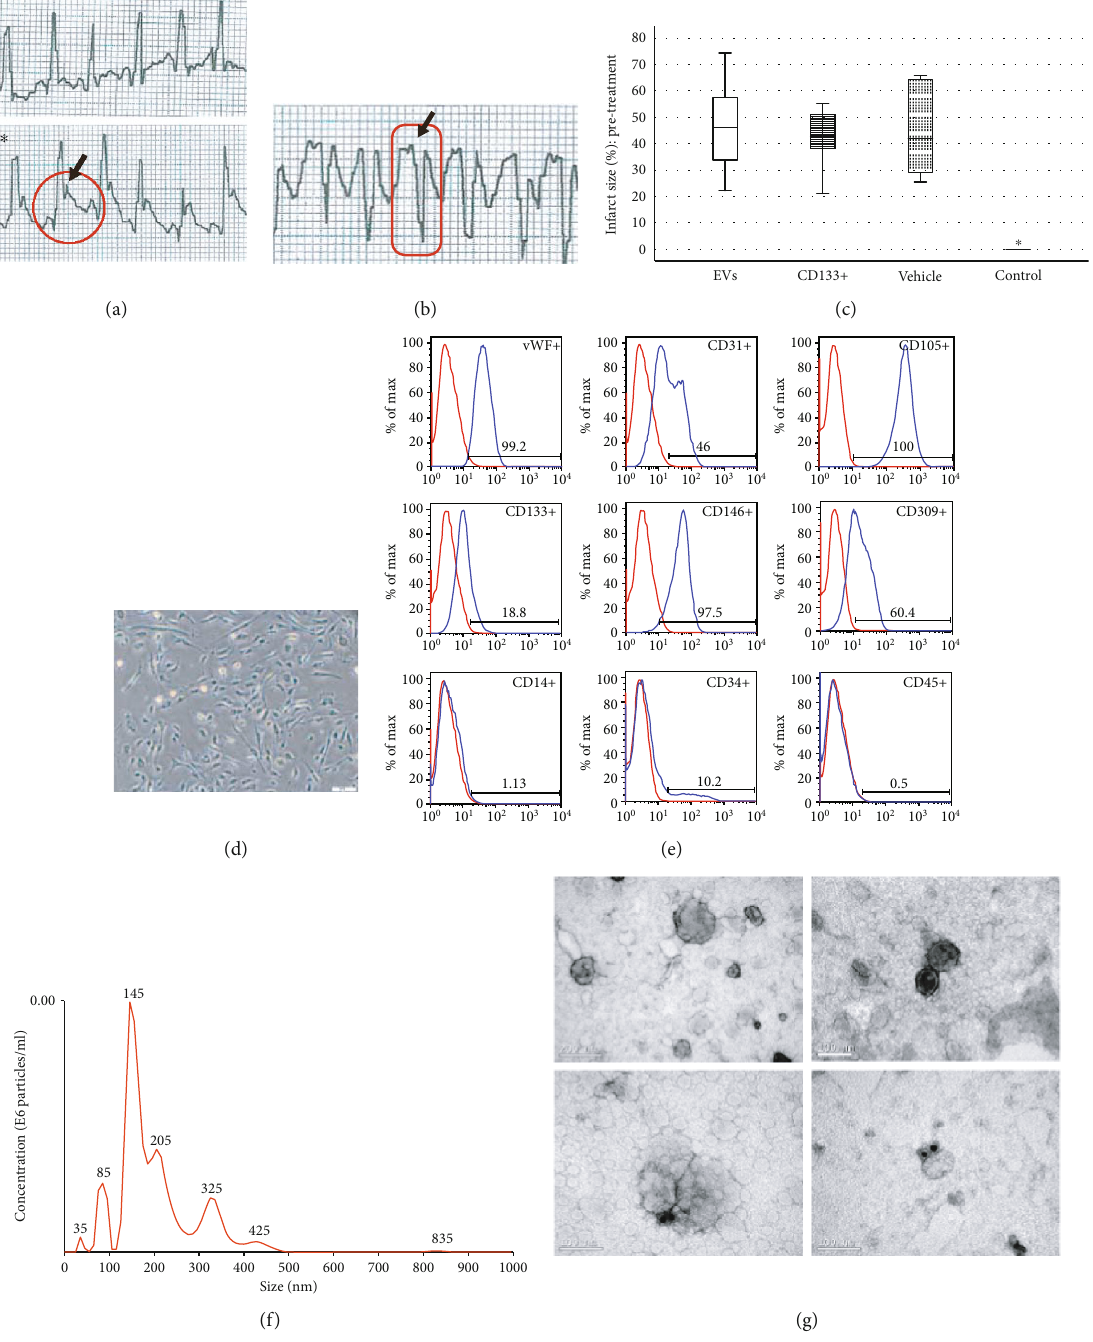
Figure 1: Characterization of the myocardial infarction model, expanded CD133 + cells, and expanded CD133 + cell-derived EVs. (a) Electrocardiographic tracing of a rat before surgery ( ° ) and after 5 minutes of coronary occlusion ( ∗ ). An increase in the T wave and the ST segment (red circle) is observed, which indicates myocardial hypoxia and con fi rms the success of the procedure. (b) Electrocardiographic tracing in DI lead performed 24 hours after coronary occlusion. The identi fi cation of negative Q wave (highlighted in red) demonstrates that the induction of AMI was successful. (c) Echocardiographic evaluations revealed infarct size similarity in all animals before treatment, indicating no signi fi cant di ff erence in initial ischemic injury among infarcted groups. The control group showed intact hearts with no evidences of IAM. (d) Representative fi eld showing the endothelial-like morphology of expanded CD133 + cells at passage 4 (magni fi cation 200x, scale bars 100 μ m). (e) Representative fl ow cytometry analysis of cell surface markers of CD133 + cells at passage 3. The isotype control is shown as a red line histogram. (f) Representative tracing of CD133 + -EV concentration and size by nanoparticle tracking analysis. (g) Representative transmission electron microscopy (TEM) images of CD133 + -EVs. The lower panel represents immunogold staining of surface proteins CD31 (left) and CD63